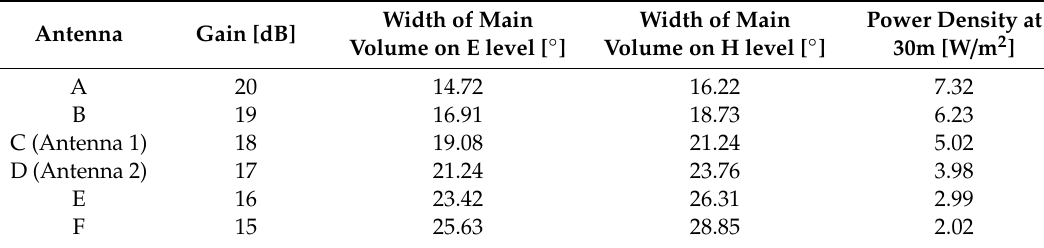
Table 1. Comparing the antenna parameters.